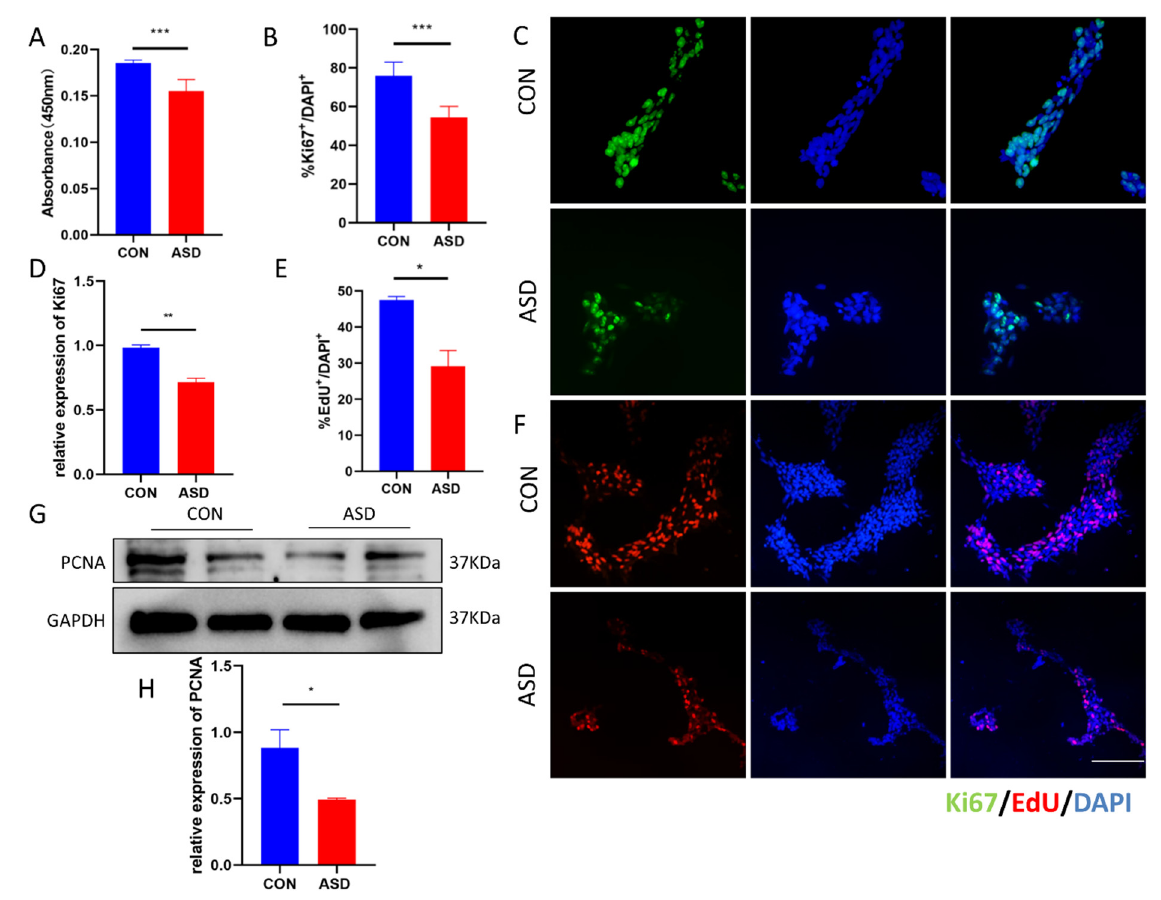
Figure 1. Impaired proliferation of ASD-NPCs. ( A ) Cell viability of CON and ASD-NPCs was assessed by CCK-8 assay. ( B , C ) CON and ASD-NPCs were immunostained with anti-Ki67 (green). DAPI (blue) was used to stain nuclei. The percentage of Ki67-labeled cells was calculated. ( D ) Relative expression of Ki67 in CON and ASD-NPCs as determined by RT-qPCR. ( E , F ) CON and ASD-NPCs were stained with DAPI (blue) and EdU (red). The percentage of EdU-labeled cells was calculated. ( G , H ) Relative expression of PCNA in CON and ASD-NPCs as determined by western blot. All data represent mean ± SEM; scale bar: 100 µm; *** p < 0.001, ** p < 0.01, * p < 0.05.